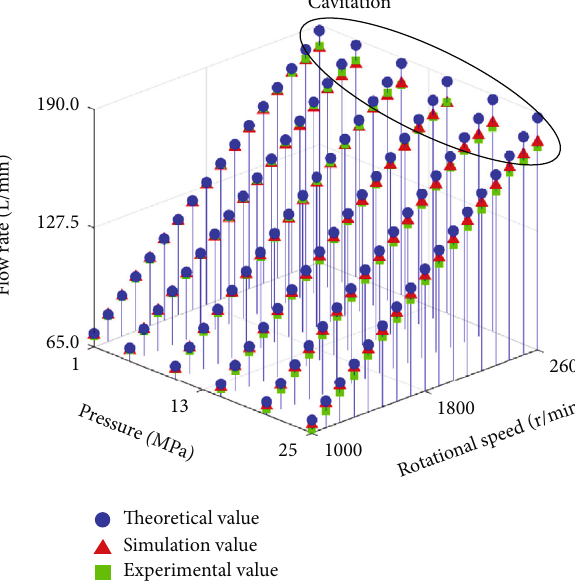
Figure 10: Comparison of theoretical fl ow rate, simulated fl ow rate, and experimental fl ow rate under di ff erent pressure and rotation speed